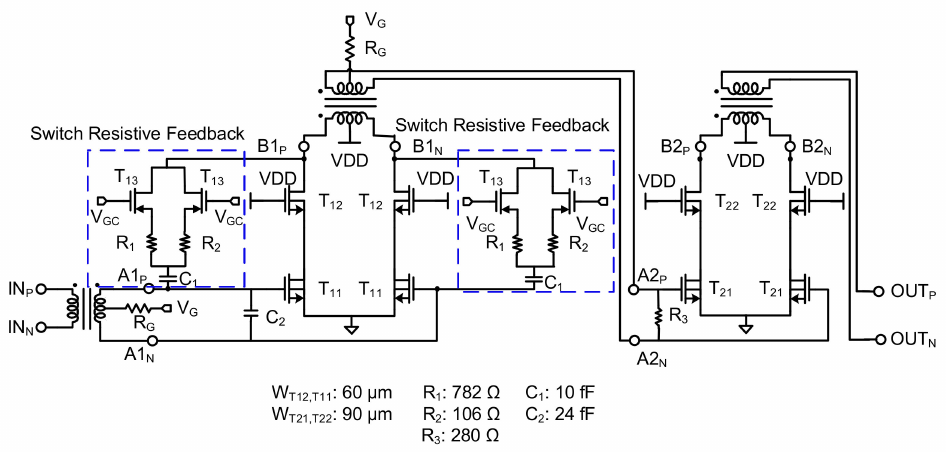
Figure 4. Schematic of 60 GHz LO buffer